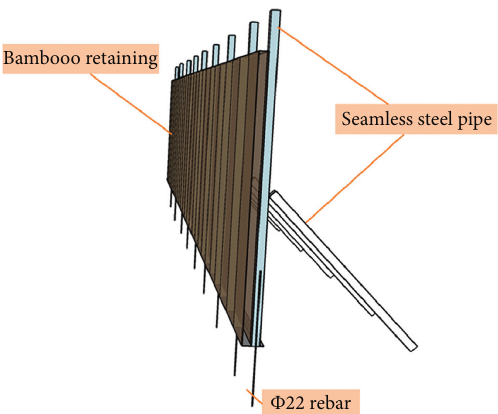
Figure 3: Composition of the protective structure in K503+ 585 ∼ 504 +018